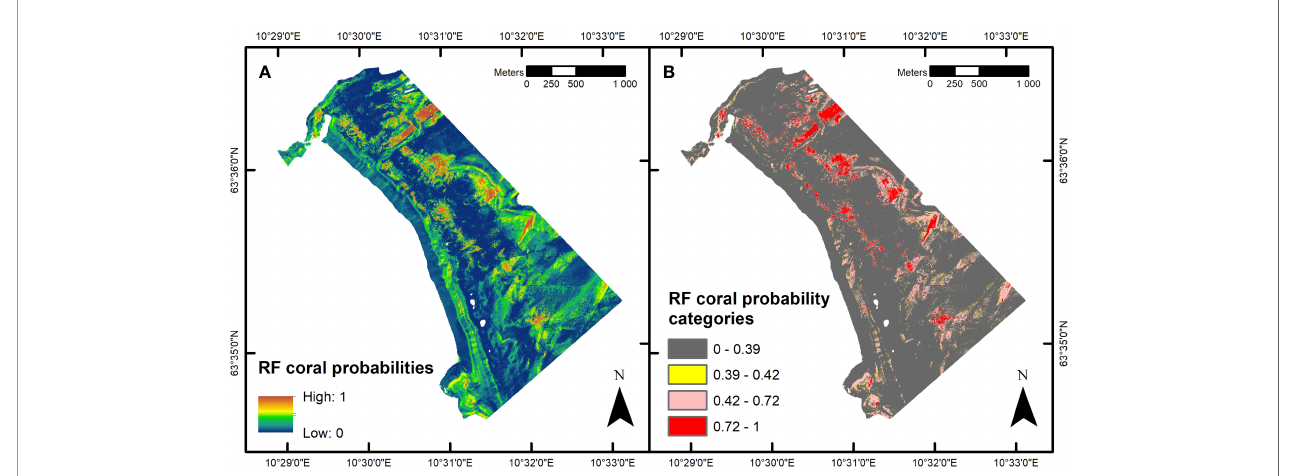
FIGURE 8 | Estimated cold-water coral (CWC) reef distribution along the Tautra Ridge. Panel (A) shows fl oating point probabilities of coral presence estimated by the random forest (RF) prediction model. Panel (B) shows CWC reef distribution estimated at different probability cutoffs (see Geomorphometric CWC Reef Classi fi cation and Figure 7 ). The maps were generated in ArcMap (v. 10.8; Esri Inc., Redlands, USA; https://desktop.arcgis.com/en/arcmap/). Projection: UTM 32N. Datum: WGS